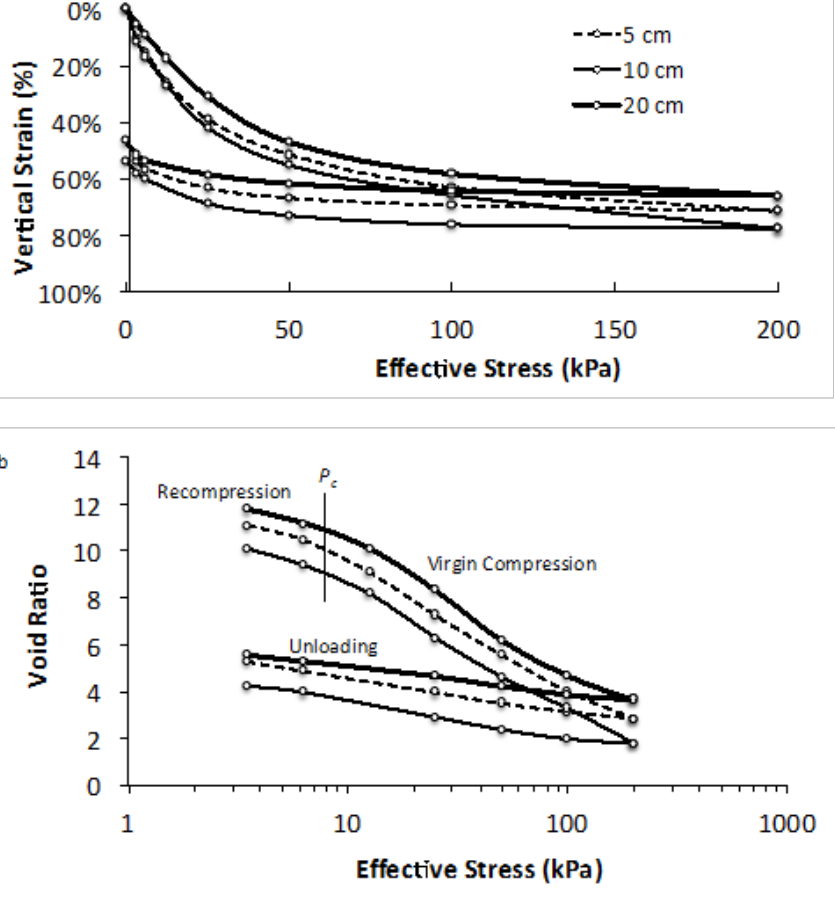
Figure 4. Loading and unloading curves for gyttja showing (a) strain and (b) void ratio, both versus log- scale effective stress.